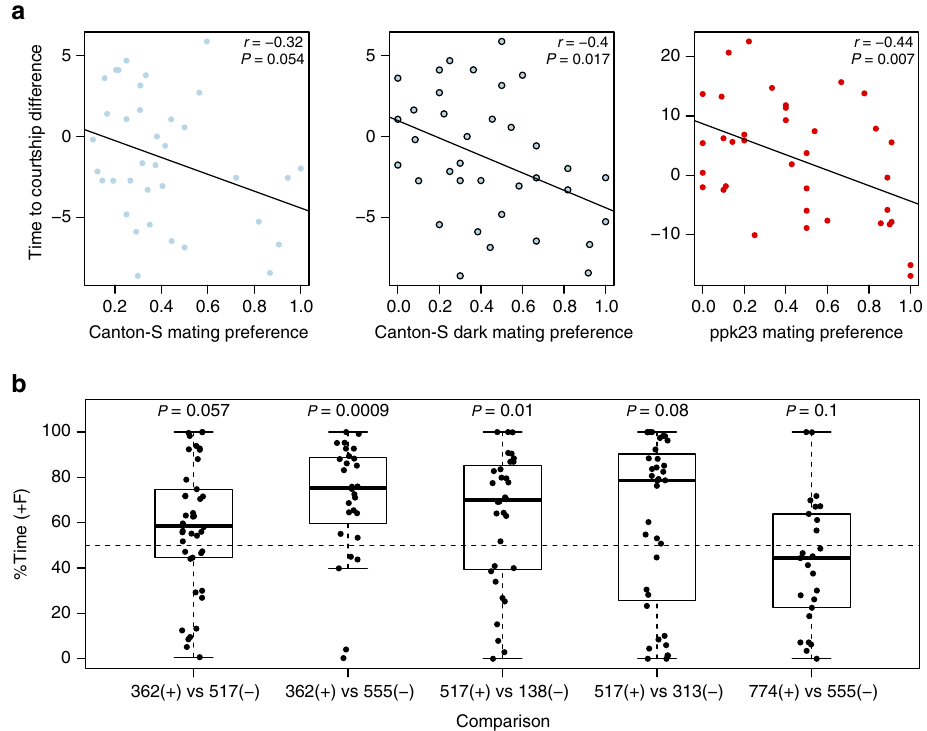
Figure 3 | Evidence for male choice among female genotypes. ( a ) Relationship between time to courtship in single-male single-female pairings and the mate choice of males in two-choice trials. Significance of Pearson’s correlation coefficients were calculated via 10,000 randomizations of the data (see methods for details). ( b ) The proportion of time males spend with the more attractive female (as determined by previous trials with active females) when males interact with two decapitated females. The specific female line choices are given along the x axis, with the attractive ( þ ) and unattractive ( (cid:2) ) female denoted for each comparison. P -values are from Wilcoxon signed-rank tests against the null hypothesis of 50% time with the more attractive female. Box boundaries represent s.e.m. and whiskers show 80th and 20th percentiles of